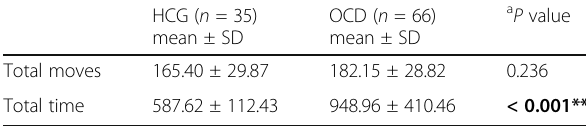
Table 4 ToL indices among the studied participants ( n =